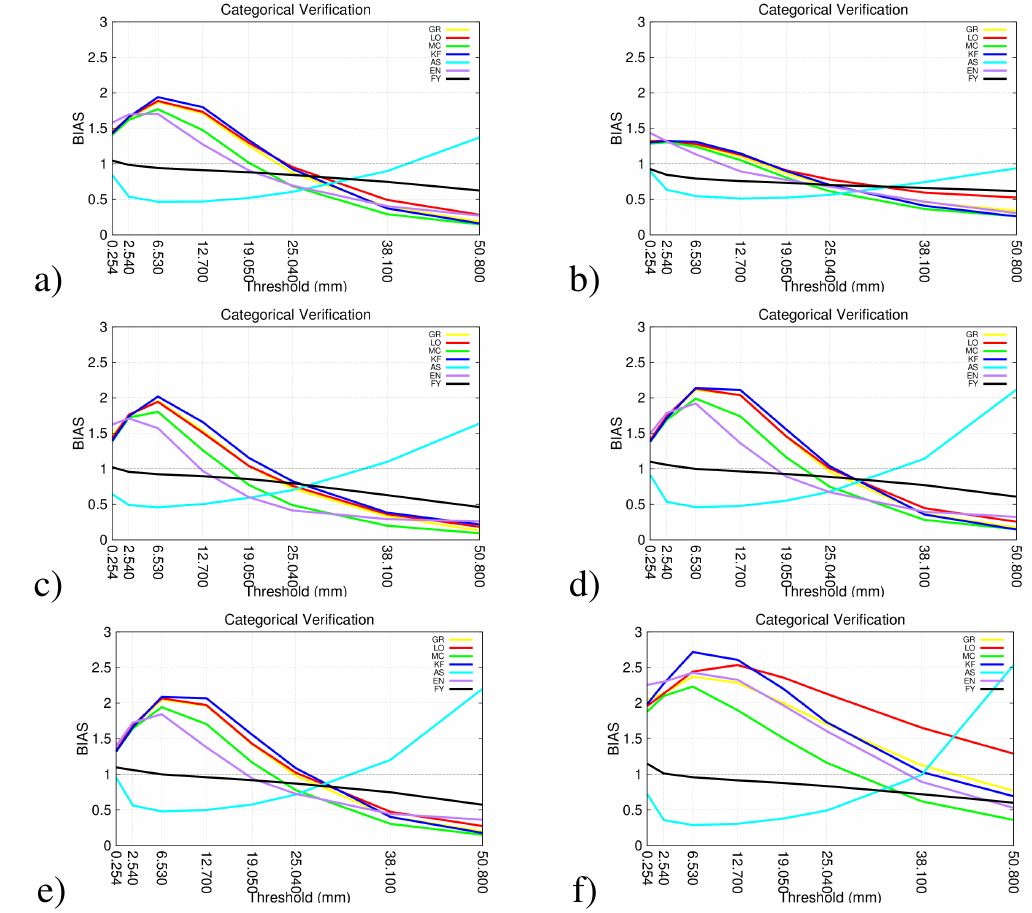
Fig. 5. Bias score vs precipitation thresholds (0.254 mm, 2.54 mm, 6.53 mm, 12.7 mm, 19.05 mm, 25.4 mm, 38.1 mm, 50.8 mm) for a) South America, b) area 2, c) area 3, d) area 4, e) area 5, f) area 6.